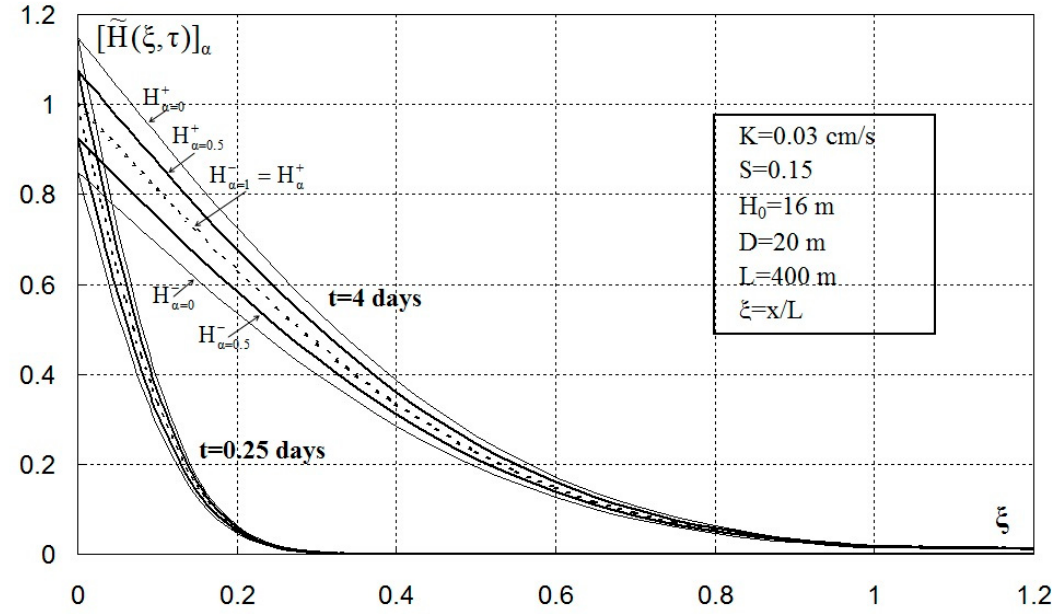
Figure 8. Dimensionless depth profiles as a function of ξ , for times t = 0.25 d and 4 d and for α = 0, 0.5, and 1.